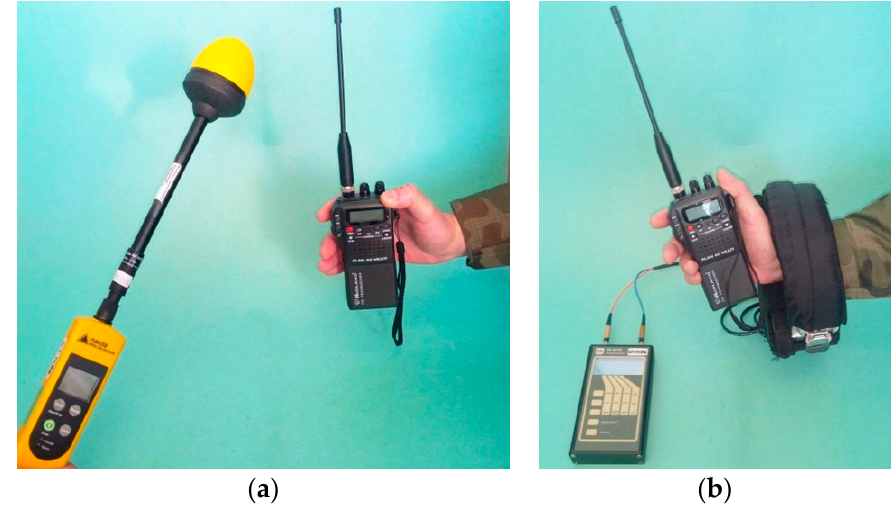
Figure 2. The examples of measurements: ( a ) electric field strength distribution near the radiophone; ( b ) limb contact current.